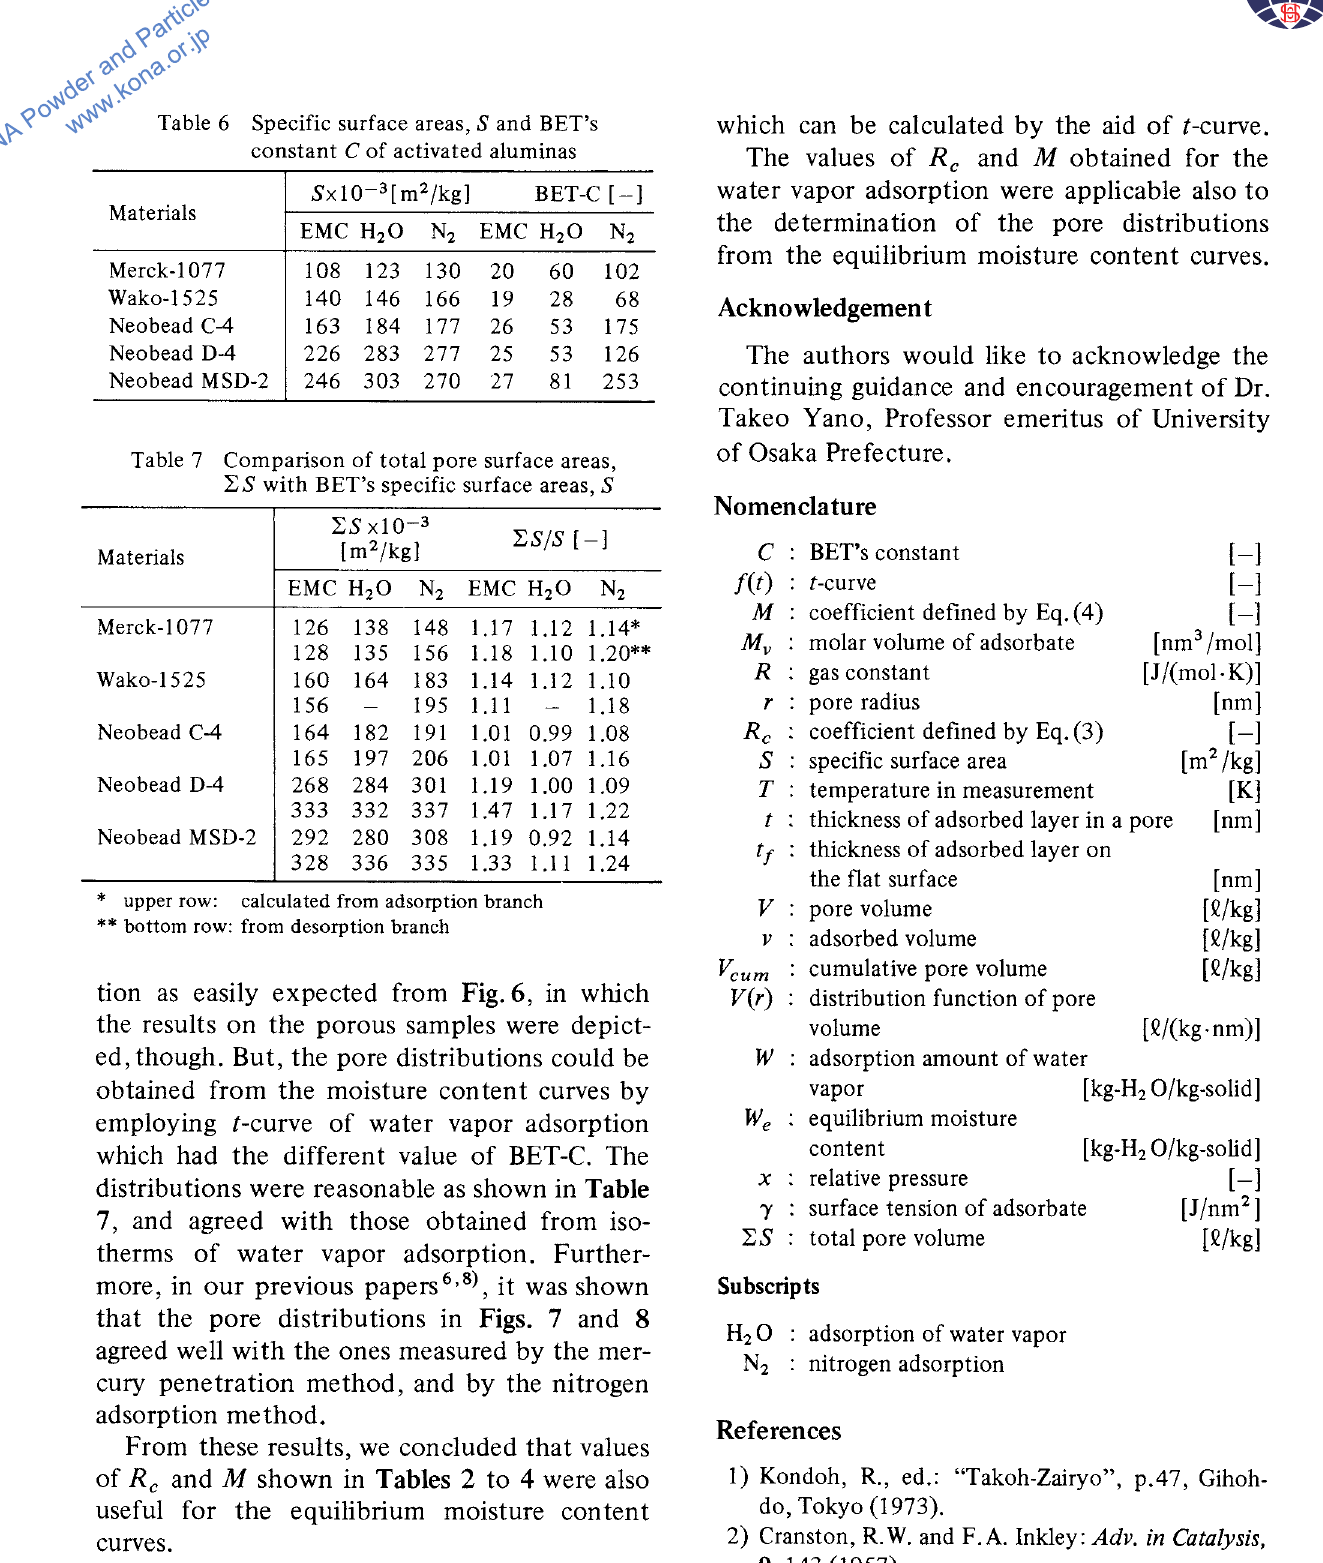
Table 7 Comparison of total pore surface areas, L.S with BET's specific surface areas, S